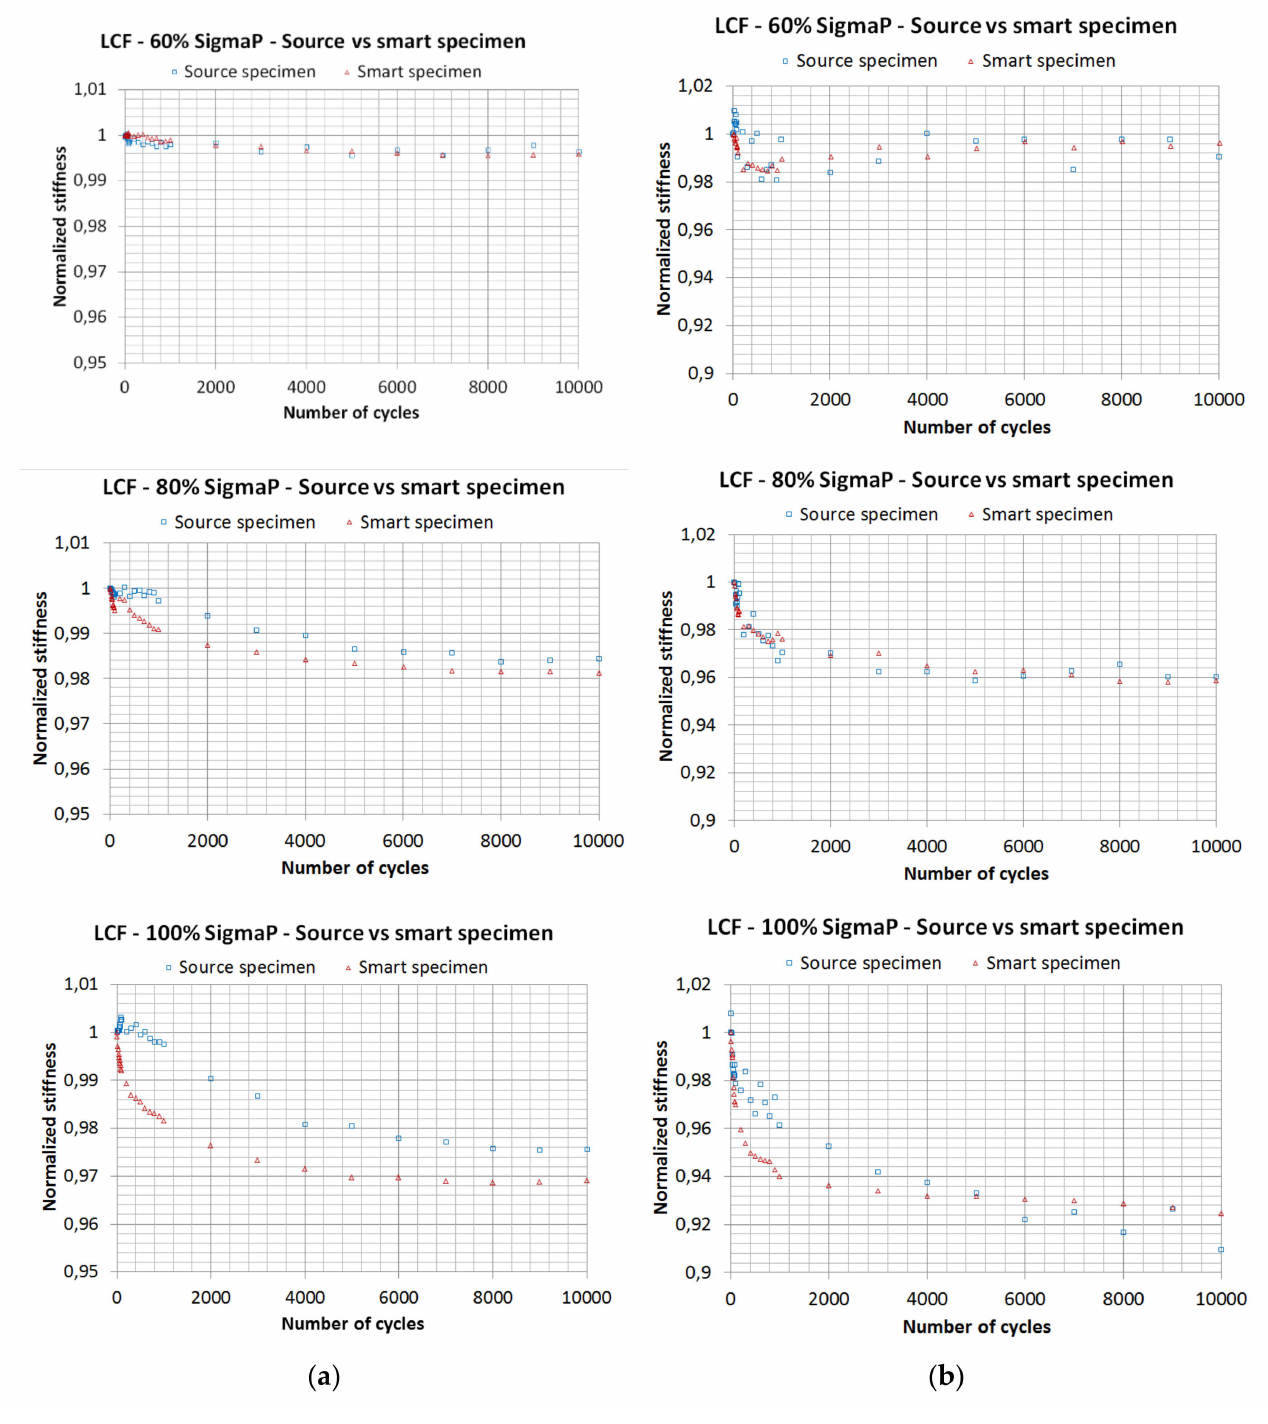
Figure 16. Source vs. smart UD and angle-ply specimen behavior under fatigue at 0.6 σ p, 0.8 σ p, and 1.0 σ p. ( a ) Fatigue tests for UD specimens. ( b ) Fatigue tests for angle-ply